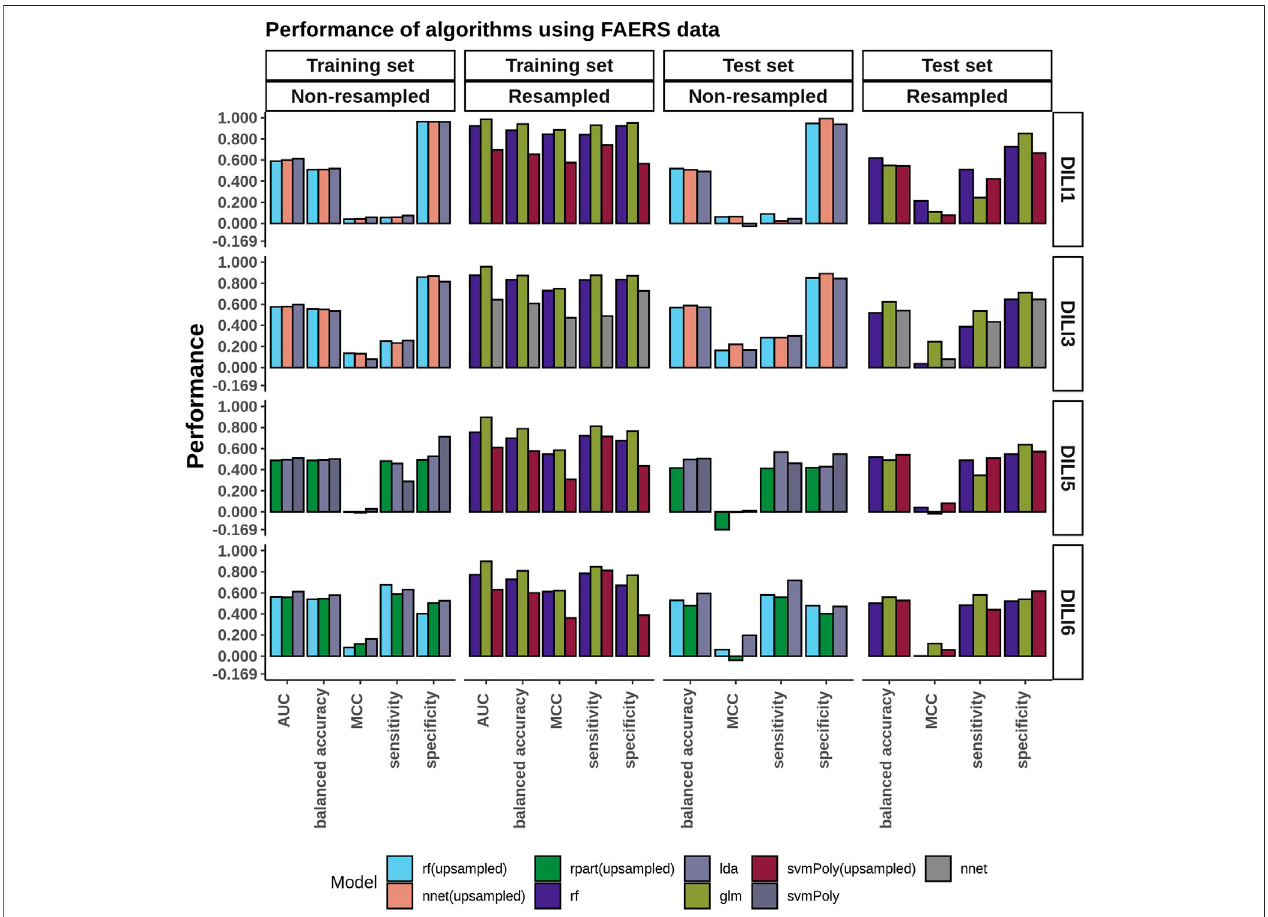
FIGURE 3 | FAERS Model Performance. Performance evaluation of the DILI predictive models built using the FAERS reporting data was conducted on both the original unbalanced and the resampled/balanced datasets. The best performing algorithm determined by AUC between GLM, IDA, NB, NNET, RF, RPART, and SVMPoly were selected. For DILI1 and DILI3, the highest accuracy was 0.62 with MCC values of 0.21 and 0.24, respectively.